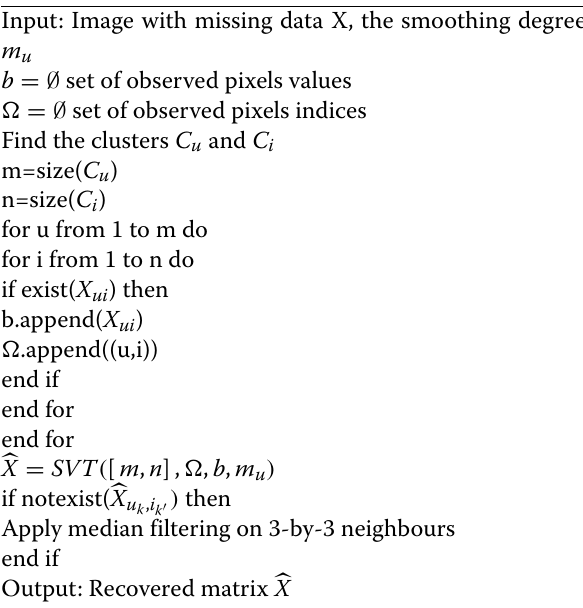
Algorithm 1 Collaborating filtering based